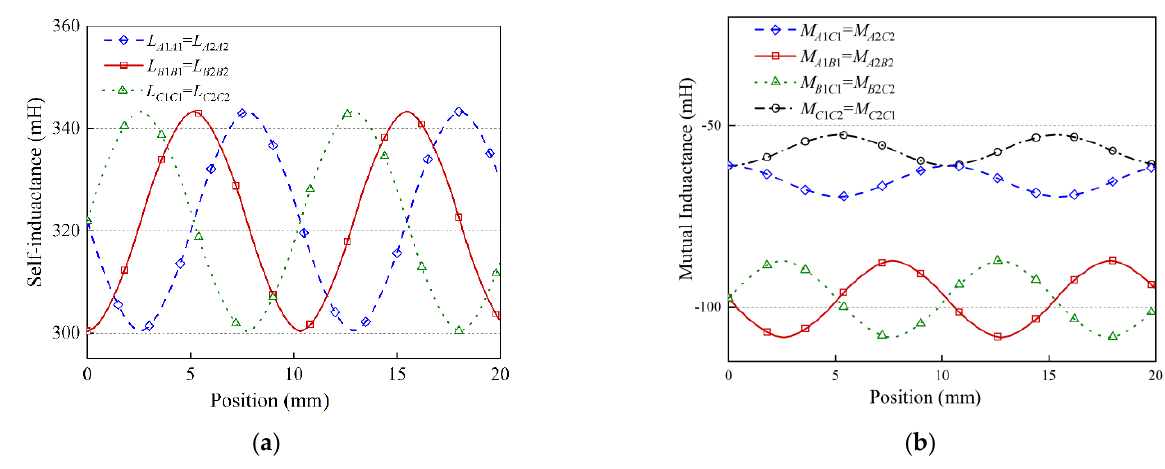
Figure 6. FEM results of the three-phase inductance. ( a ) The self-inductance of each module. ( b ) The interior and external mutual inductance of each module.